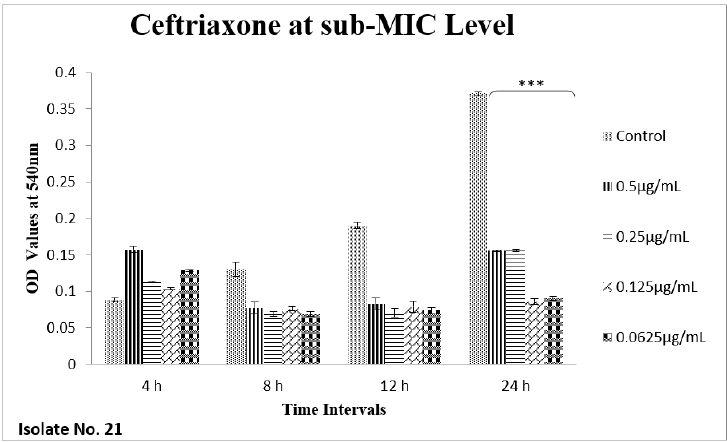
Figure 4. Shown are the effects of ceftriaxone on E. coli biofilms at different time intervals (OD 540 nm). Overall significant reduction (*** p value < 0.001) in biofilm formation was observed up to 24 h, when compared to the control samples.